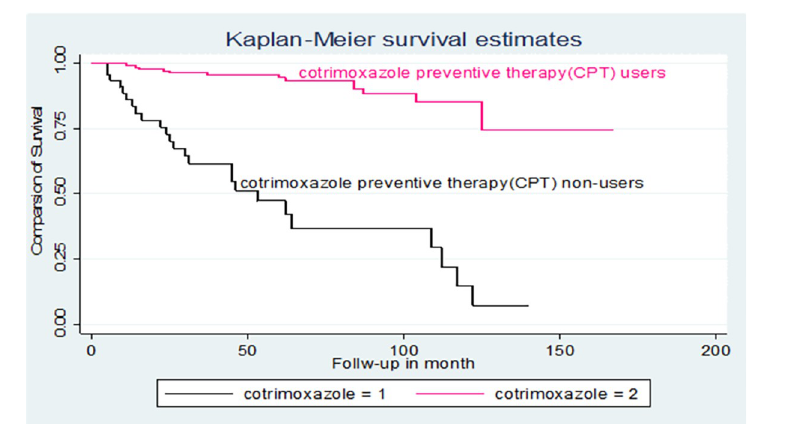
Fig 4. Kaplan-Meier of survival curve of among TB and HIV co-infected children CPT non-users in northwest Ethiopia hospitals,